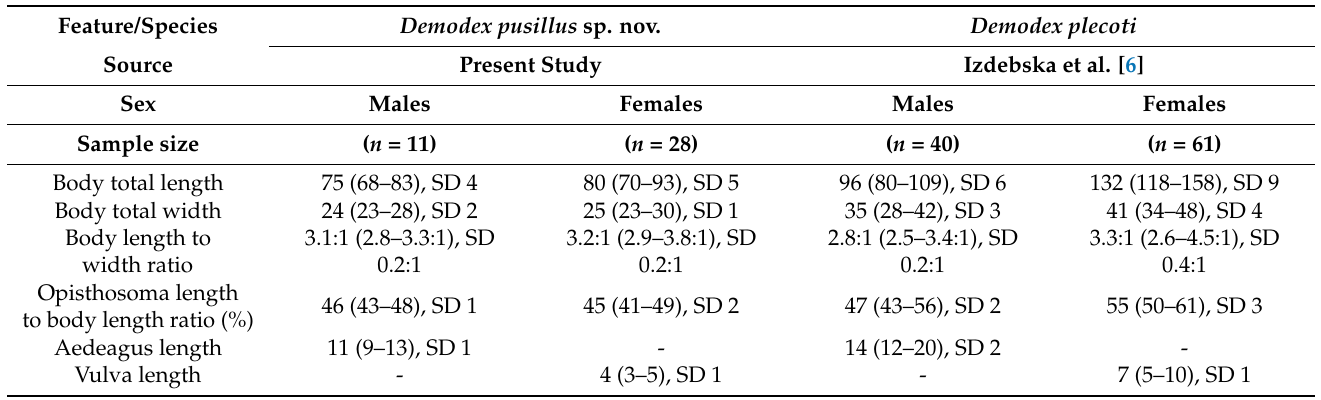
Table 2. Morphometric comparison between Demodex pusillus sp. nov. and Demodex plecoti . Feature/Species Demodex pusillus sp. nov. Demodex